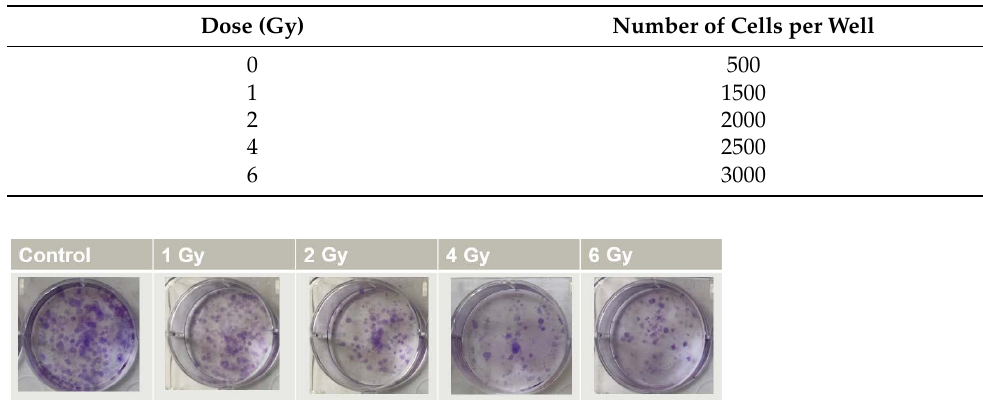
Figure 10. Clonogenic assay performed in 6-well plates, with clones produced by DU145 prostate cancer cells exposed to different doses of IR.